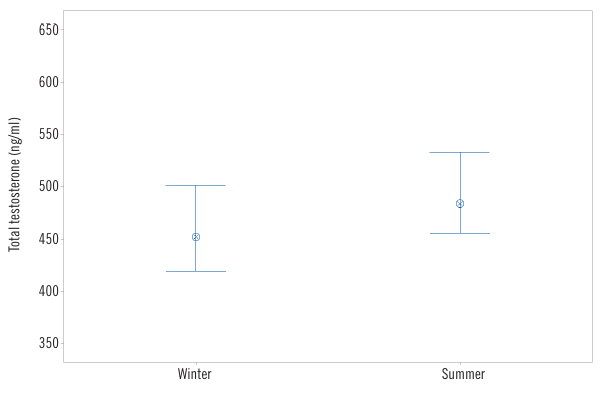
FIGURE 3 – Distribution of median values of total testosterone in the morning period during winter and